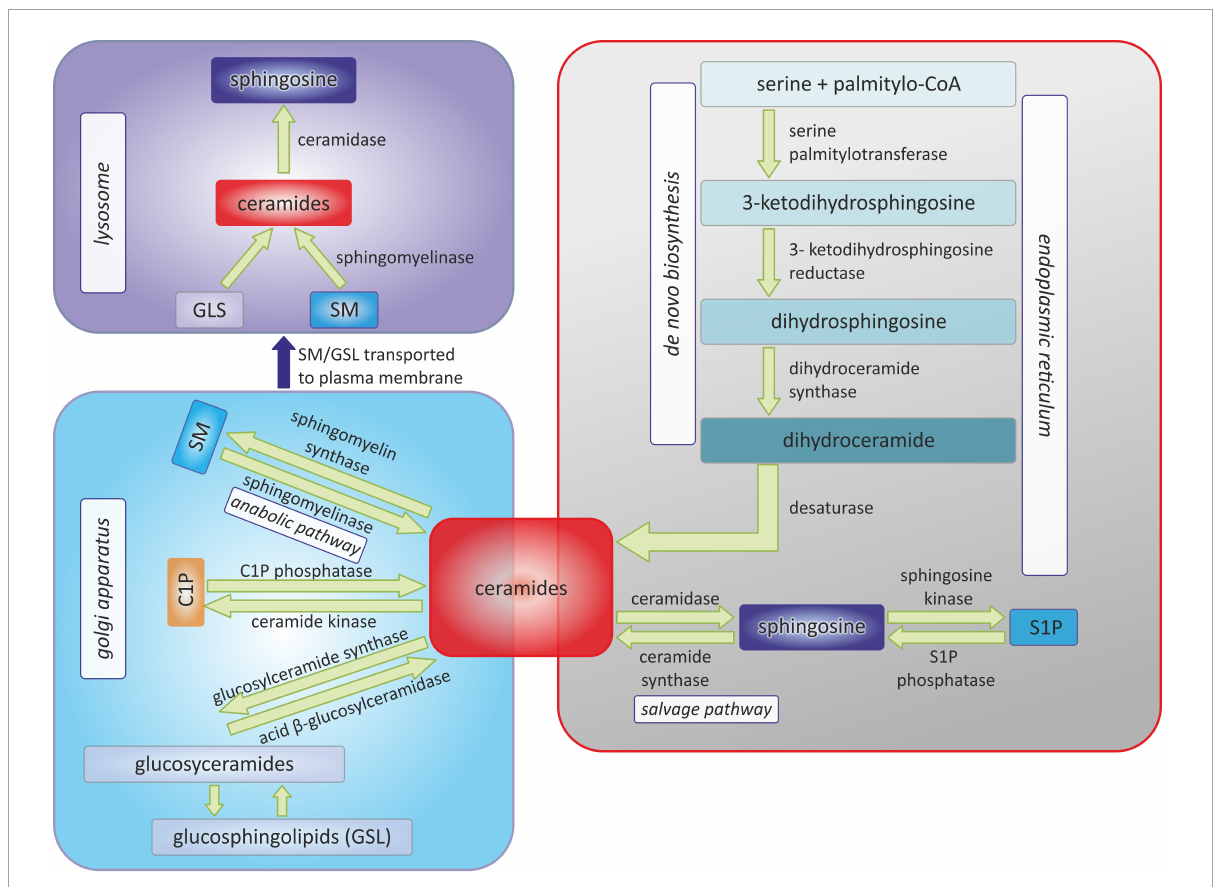
FIGURE1 Pathways of sphingolipids metabolism. C1P, ceramide-1-phosphate; SM, sphingomyelin; S1P,